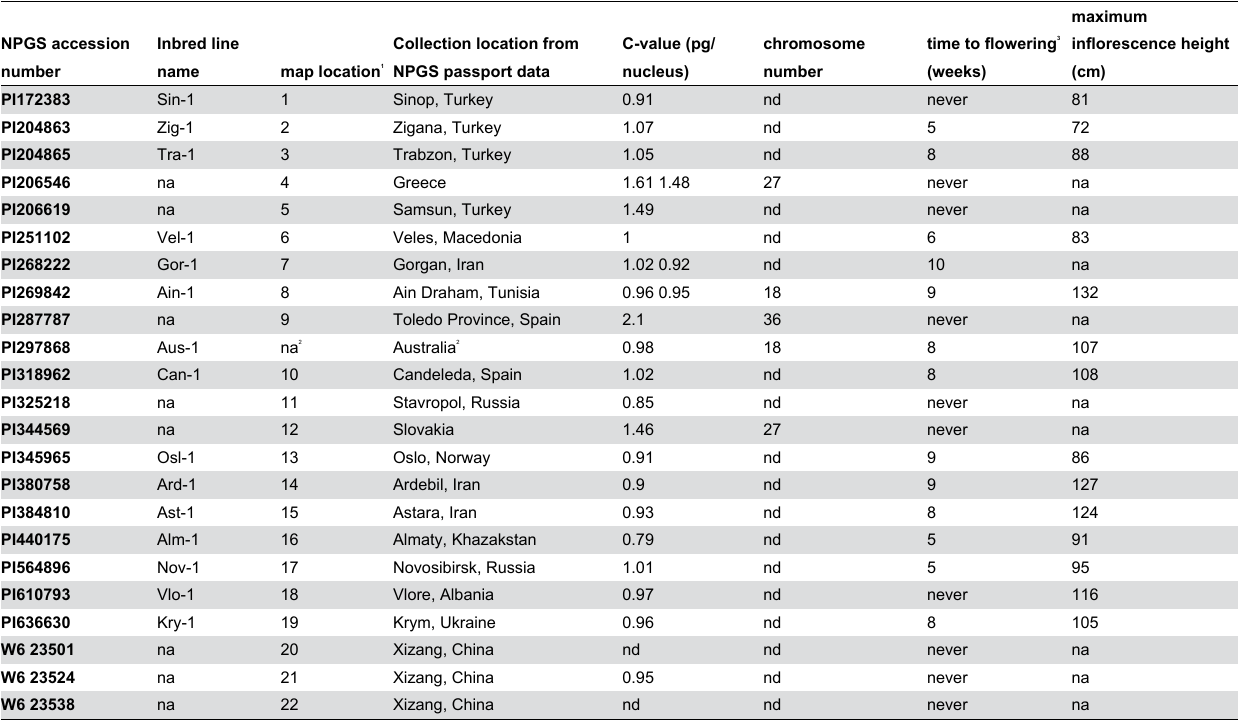
Table 1. Lines used in this